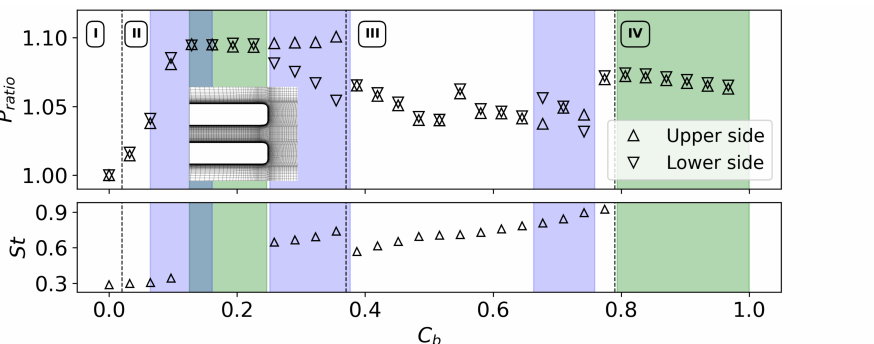
Figure 4. Evolution of the temporal averaging of the static base pressure ratio ( P ratio = P base / P baseNB ) and the Strouhal number ( St = f D / U ∞ ) when the base bleed intensity is increased. Those mass flows related to non-symmetrical trailing edge flows are highlighted in blue, while those associated with the disappearance of vortex shedding are marked in green. Reproduced from Martinez-Cava et al. [19]. Copyright © 2021, published by Elsevier Masson SAS. All rights